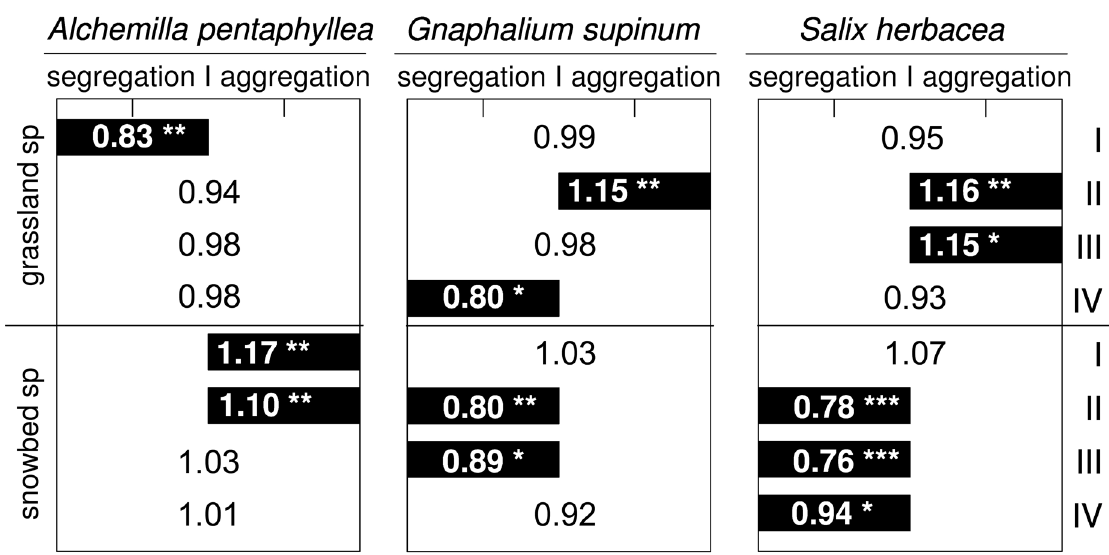
Fig. 4. Spatial relationships of dominant snowbed species with two contrasting species groups along the snowmelt gradient. Aggrega- tions and segregations were detected by calculating the observed variance ratio (RV ) and comparison to the null model with ran- obs domly distributed species. A value of RV = 1 means a random distribution of species, values of RV < 1 suggest segregation, RV > 1 obs obs obs indicate aggregation. The three dominant species are Alchemilla pentaphyllea (I: 96 occurrences, II: 111, III: 116, IV: 112), Gnaphalium supinum (I: 107, II: 84, III: 75, IV: 77), and Salix herbacea (I: 99, II: 86, III: 101, IV: 115). Species groups: alpine grassland species (snowmelt date I: 13 species, II: 11, III: 9, IV: 2) and subordinate snowbed species (I: 5, II: 7, III + IV: 8). Significant RV -values in obs filled columns are marked with * (p < 0.05), ** (p < 0.01), *** (p < 0.001). Snowmelt dates: I = 2 Jun 2003, II = 9 Jun 2003, III = 16 Jun 2003, IV = 23 Jun 2003. n for each snowmelt date = 120 circles.